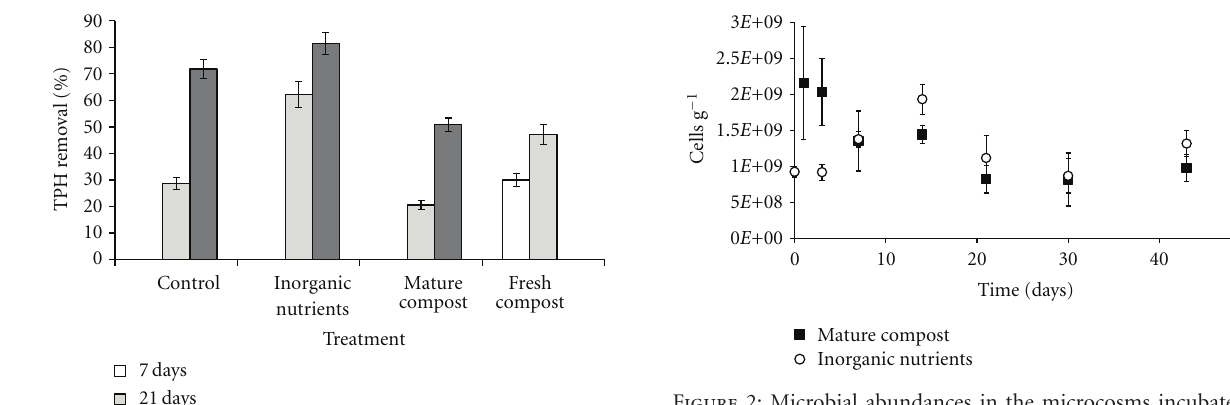
Figure 2: Microbial abundances in the microcosms incubated in aerobic conditions, amended with mature compost and inorganic nutrients. Error bars indicate standard deviation of the means. Table 1: Factors and levels in the anaerobic pretreatments of the two-step anaerobic-aerobic treatment.